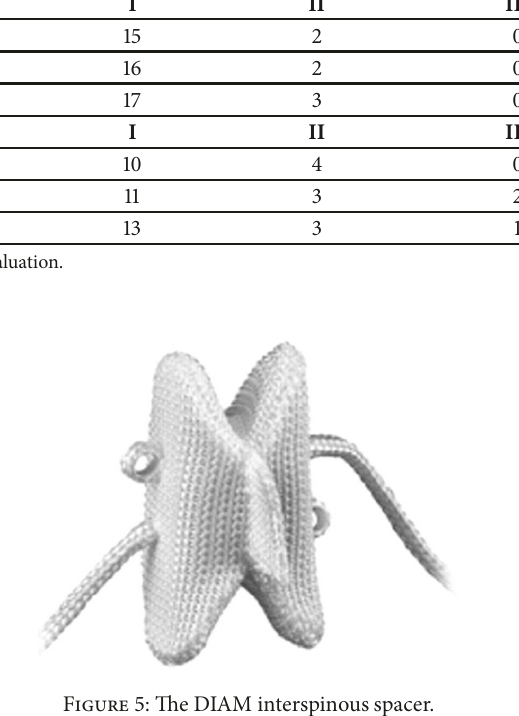
Figure 3: MRI images of the Modified Grading System for Lumbar Disc Degeneration. This material is used after author’s permission [17]. Table 5: Pfirrmann classification in the 2 nd supradjacent and subjacent segment preoperatively till the final follow-up. 2nd Supradjacent Group